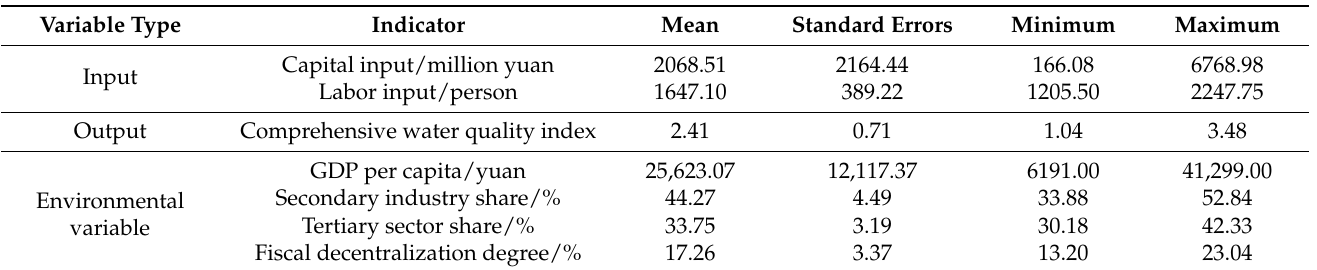
Table 1. Results of descriptive statistics for each variable.